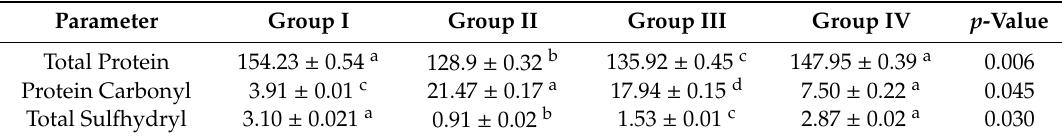
Table 4. E ff ect of EEAB on protein damage (protein carbonyl and protein sulfhydryl) in liver tissue of rats intoxicated with CCl 4